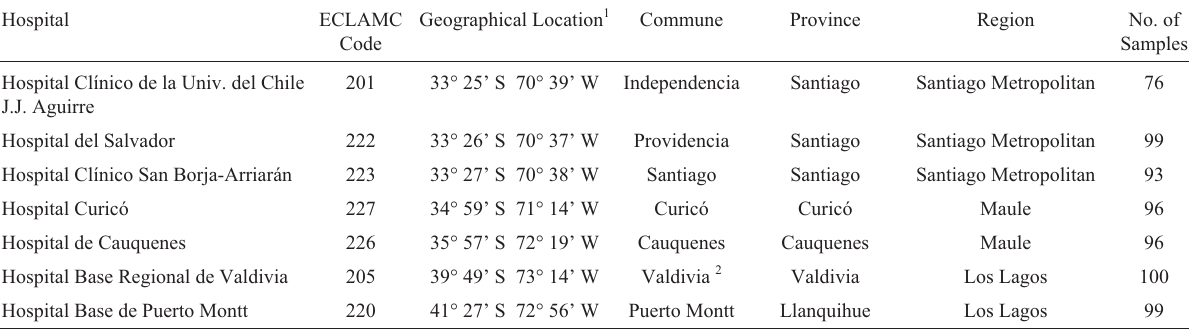
Table 1 - Hospitals from each Chilean commune, their geographical location and sample